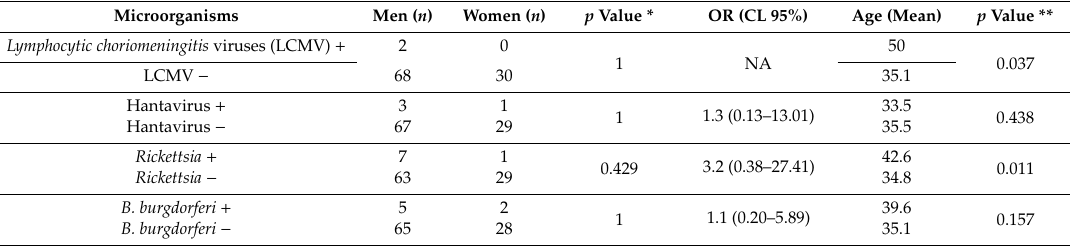
Table 1. Data from the statistical analysis of the results.